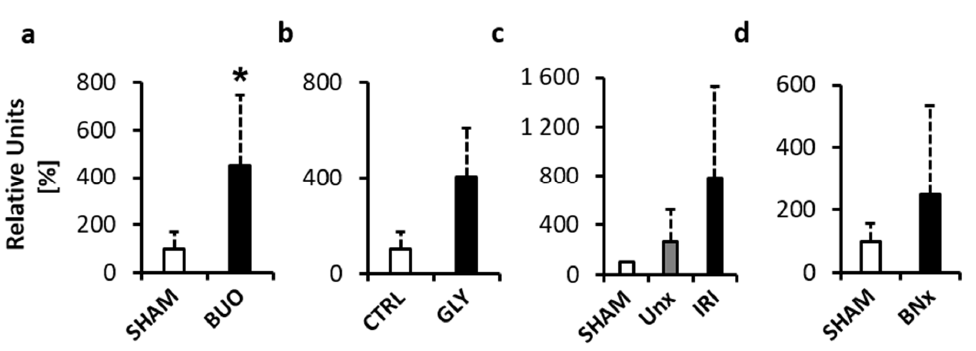
Figure 3. Nuclear ecDNA (ncDNA) measured in plasma of mice with acute kidney injury (AKI). ( a ) Bilateral ureteral obstruction. ( b ) Glycerol-induced AKI. ( c ) Ischemia–reperfusion injury. ( d ) Bilateral nephrectomy. * denotes p < 0.05. Data are presented as mean + SD. BUO—bilateral ureteral ligation, GLY—glycerol-induced AKI, UNx—unilateral nephrectomy, IRI—ischemia–reperfusion injury,